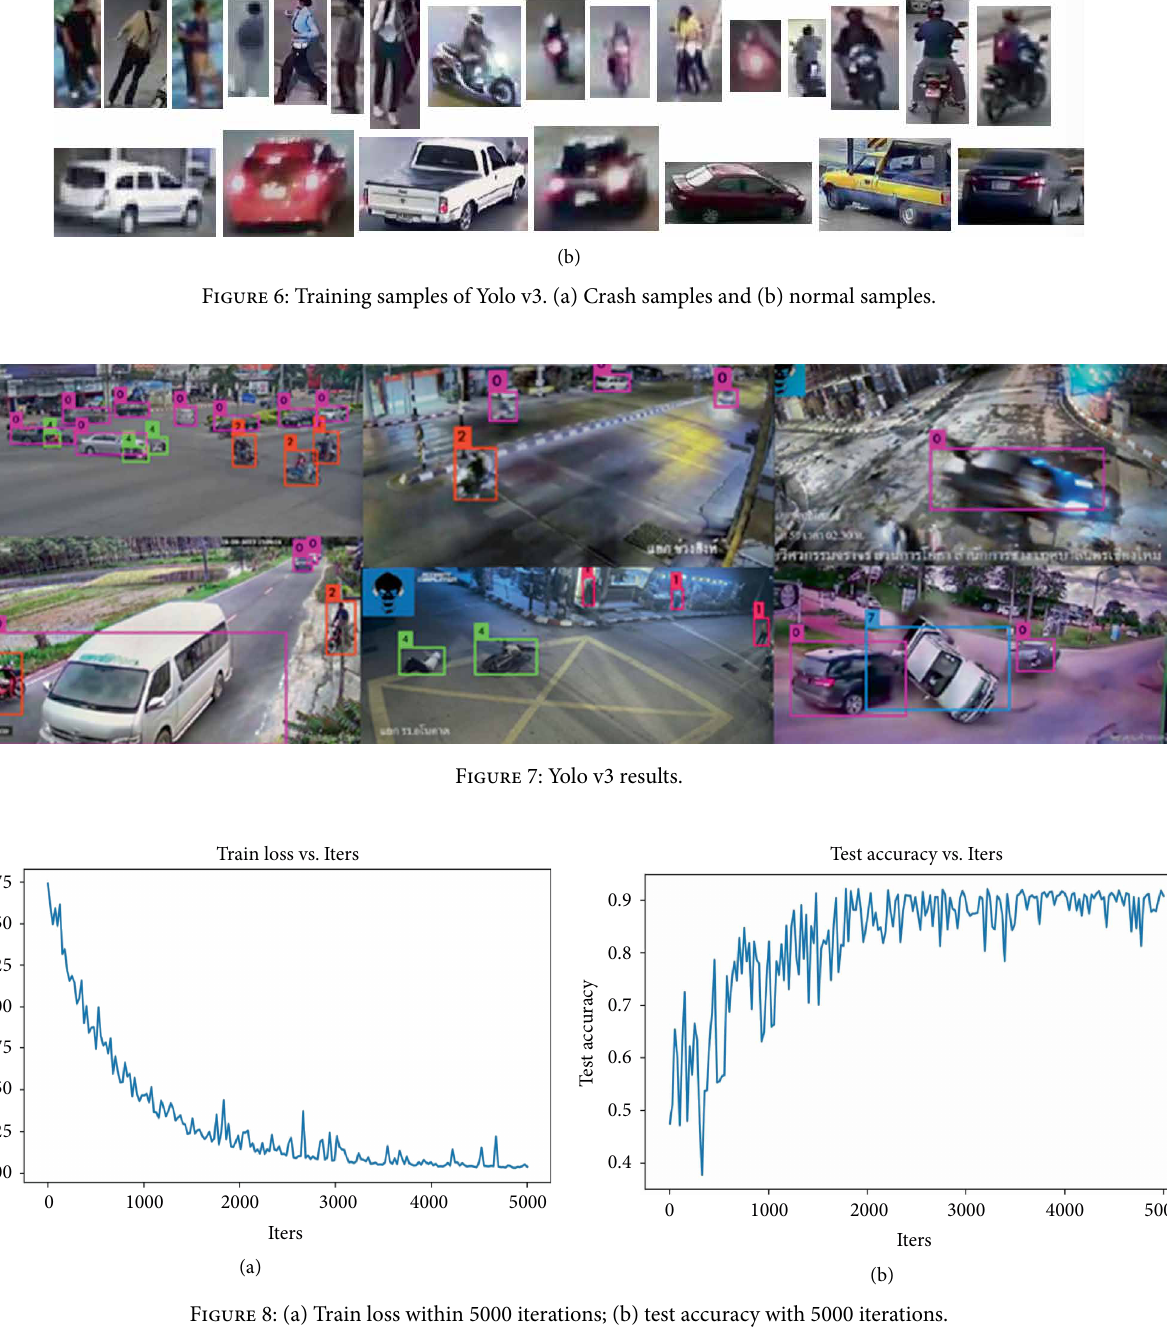
Figure 8: (a) Train loss within 5000 iterations; (b) test accuracy with 5000